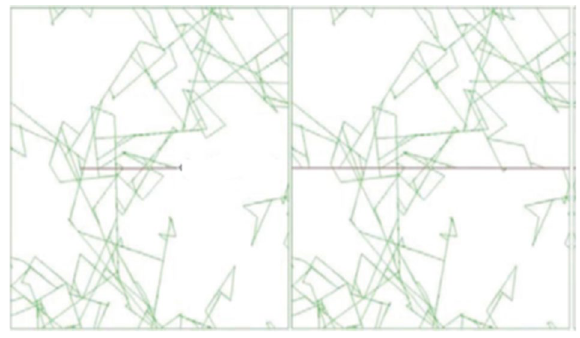
Fig. 14 Part of the hydraulic fracture in the area where the coales- cence of the main factor of production